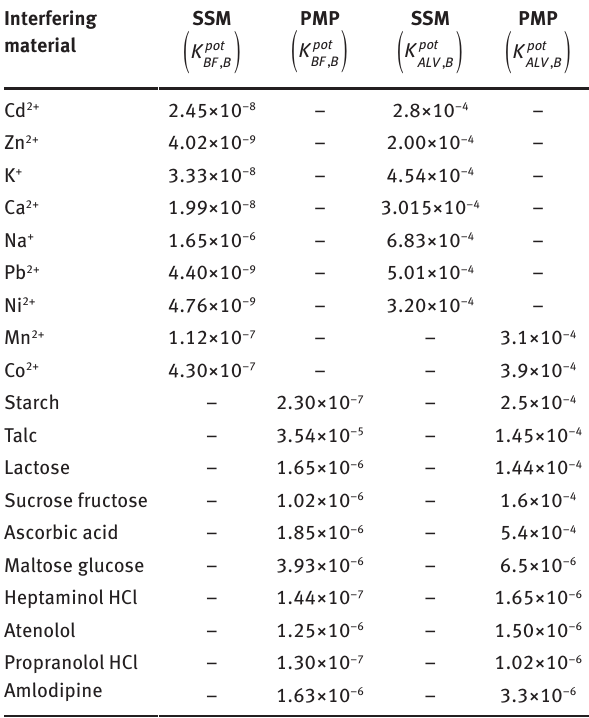
Table 3: Potentiometric selectivity coefficients K drugBpot